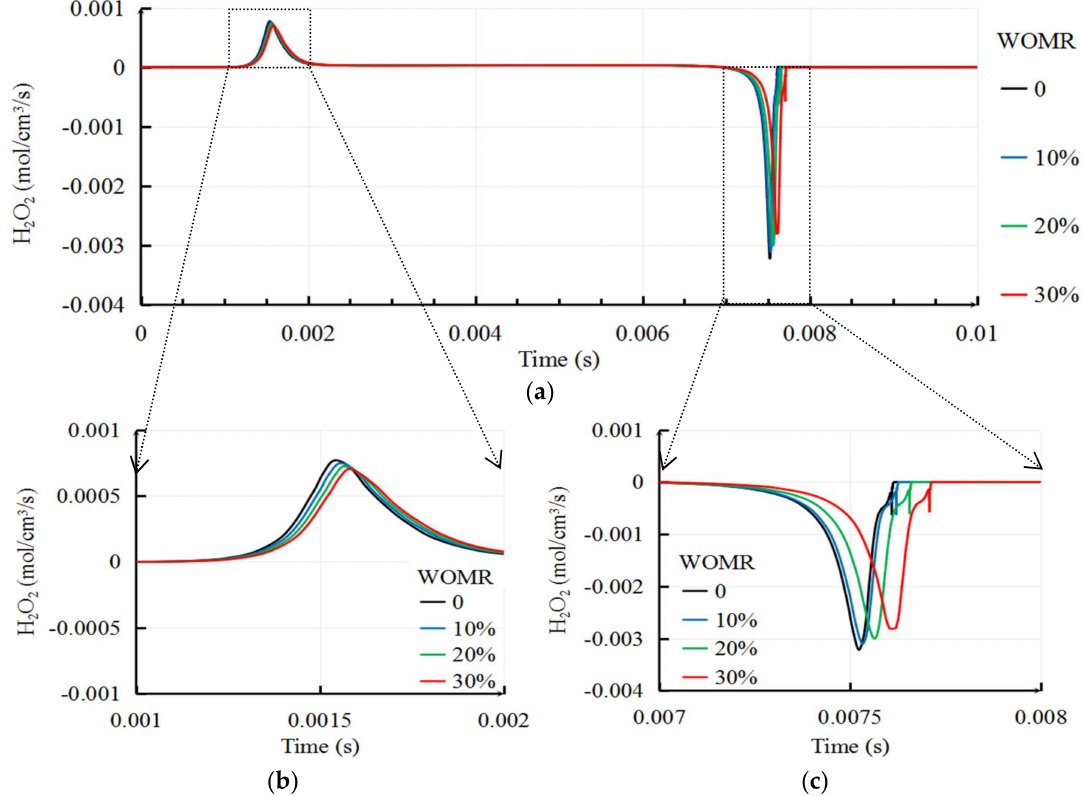
Figure 2. Reaction rate of H 2 O 2 at different WOMR ( λ = 1). ( a ) Global profile comparison; ( b ) Detail profile comparison 1; ( c ) Detail profile comparison